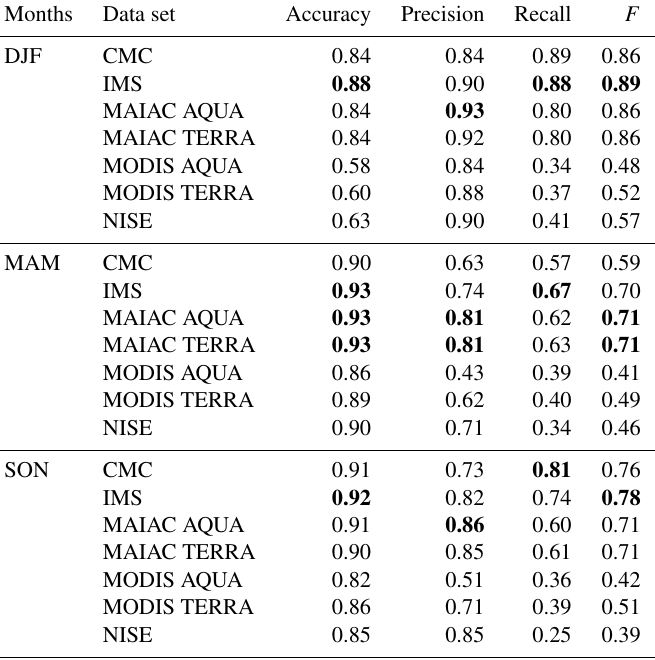
Table A1. Evaluation of daily snow extent data set performance by season for 2015. GHCN-D surface observations are used as “truth”. All products are regridded to a common 4km resolution. The highest value for each metric/season is shown in bold.